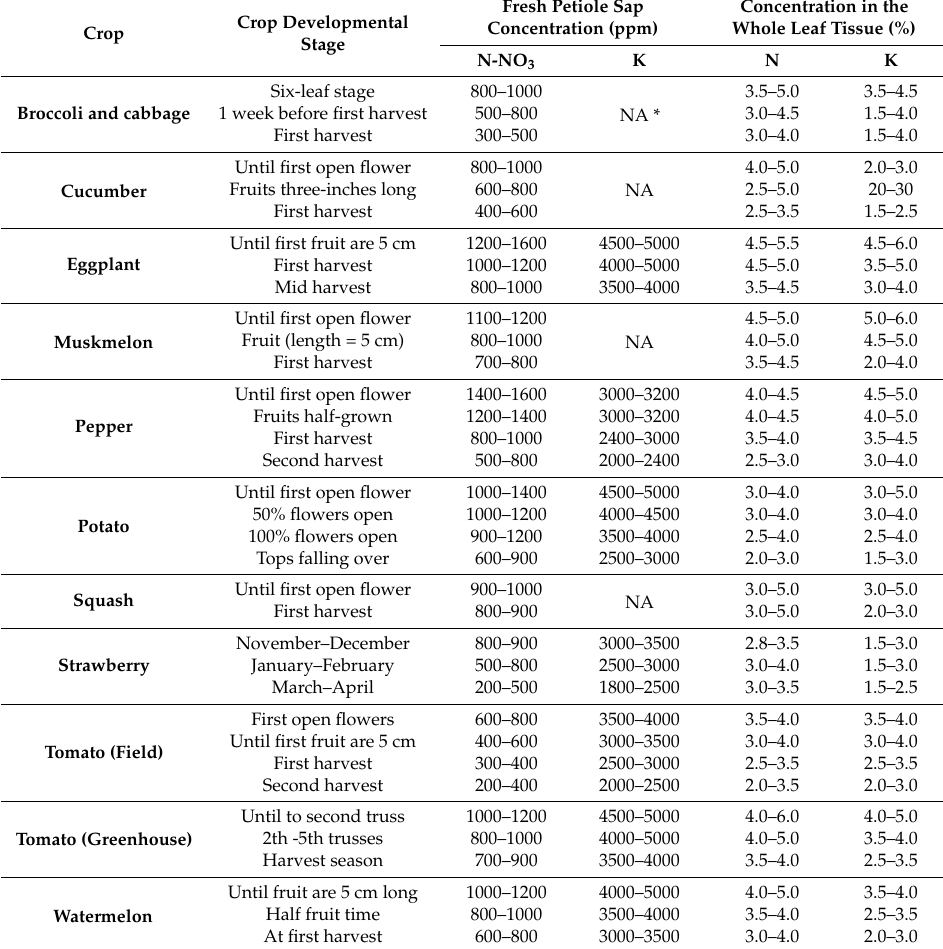
Table 4. References values for different vegetable crop grown in Florida (Source: Hartz and Hochmuth [27]; Hochmuth